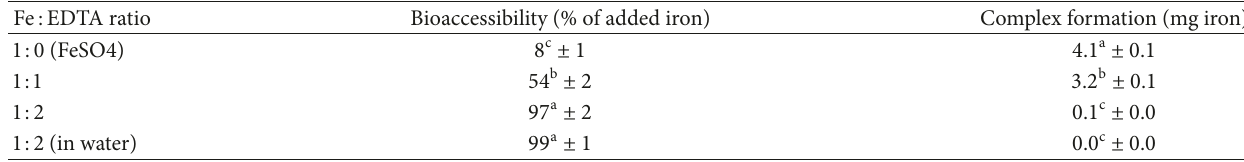
Table 3: Bioaccessibility of iron in fortified water and tea when added in different Fe: EDTA ratios. Fe: EDTA